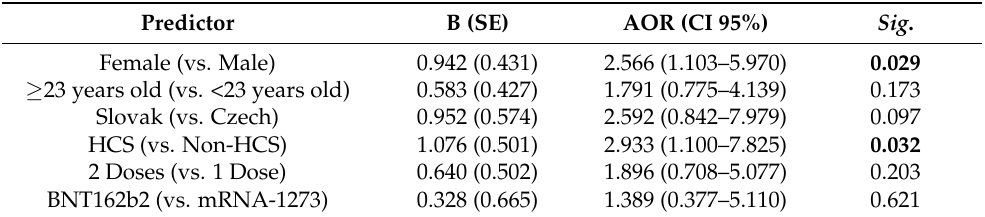
Table 7. Predictors of mRNA-based COVID-19 vaccines side effects (general side effects) experienced